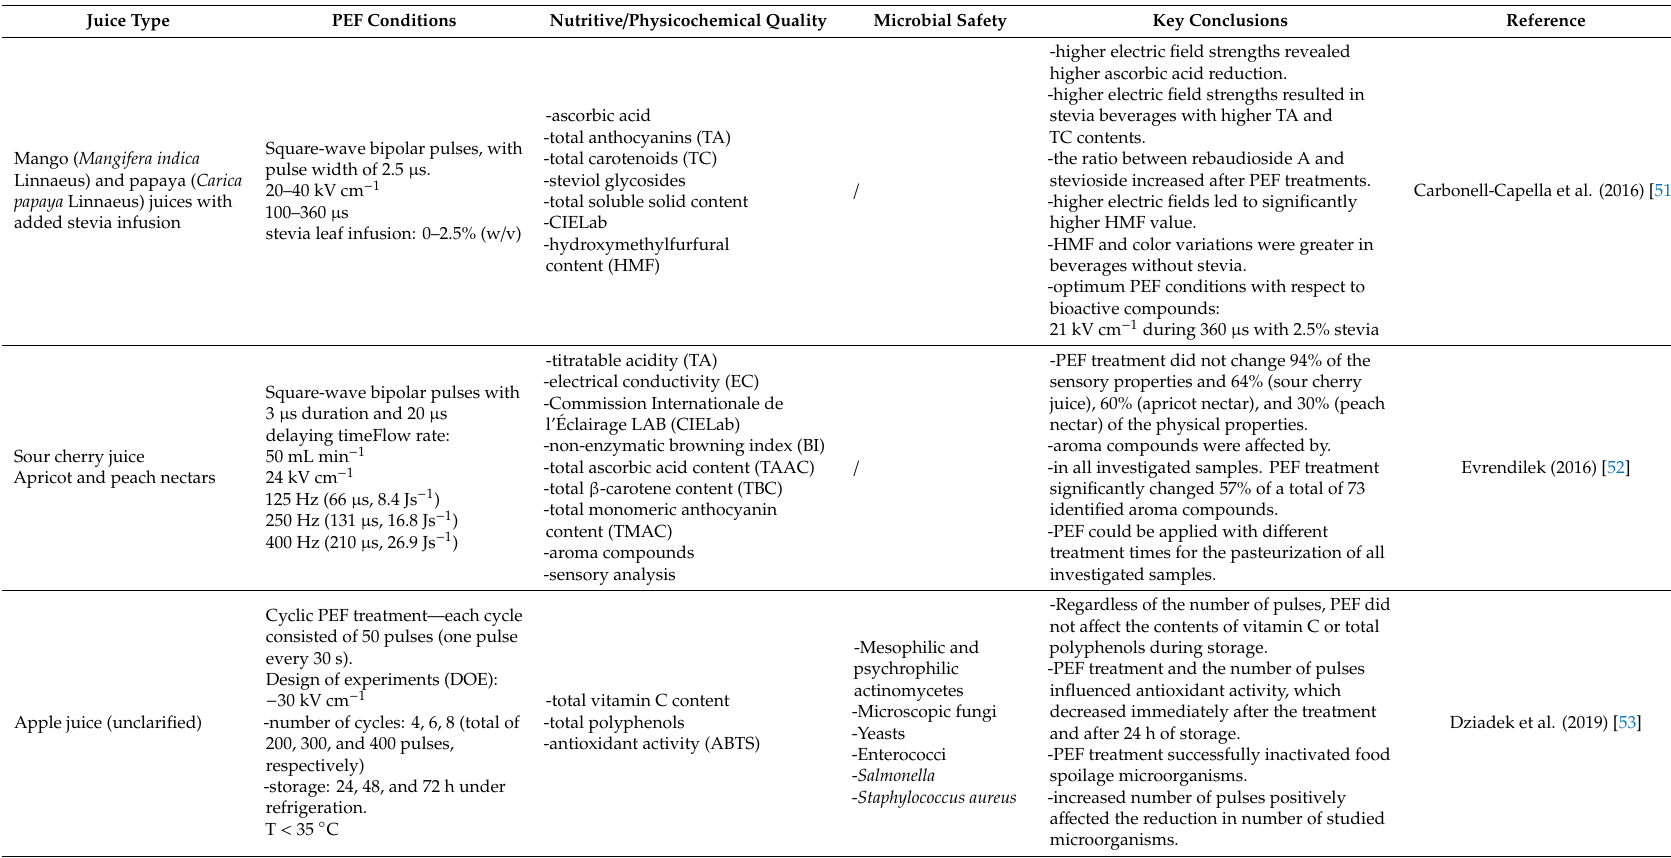
Table 1. The application of pulsed electric field (PEF) treatment for the preservation of functional fruit juices and beverages over the last 5 years. Juice